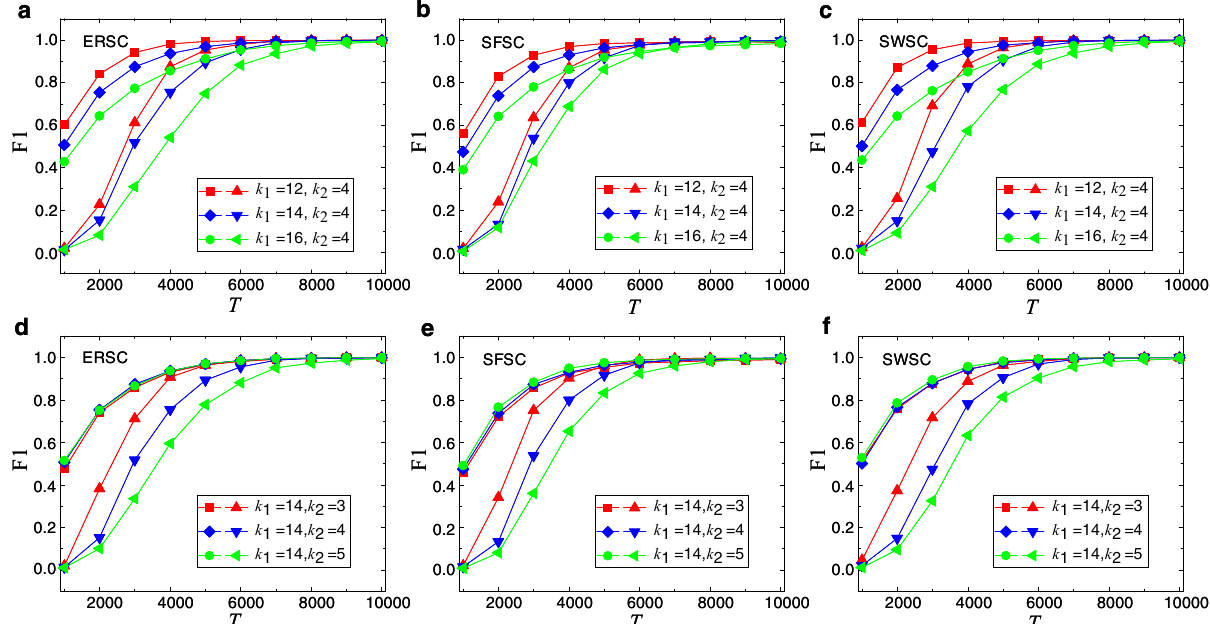
Fig. 1 Reconstruction performance for synthetic 2-simplicial complexes. Shown is F1 score as a function of the length T of the observational binary time series for three synthetic 2-simplicial complexes: ( a , d ) random simplicial complex (ERSC), ( b , e ) scale-free simplicial complex (SFSC), and ( c , f ) small- world simplicial complex (SWSC). In each panel, squares, diamonds and circles denote the performance of reconstructing the two-body connections while triangles with different orientations demonstrate the performance of reconstructing three-body connections, and different values of the average degree are distinguished by colors. All simplicial complexes have the same size N = 200. Other parameter values are α = 0.8, ω = 2.4, ρ 0 = 0.2, and μ = 1. The results are averaged over fi ve realizations.